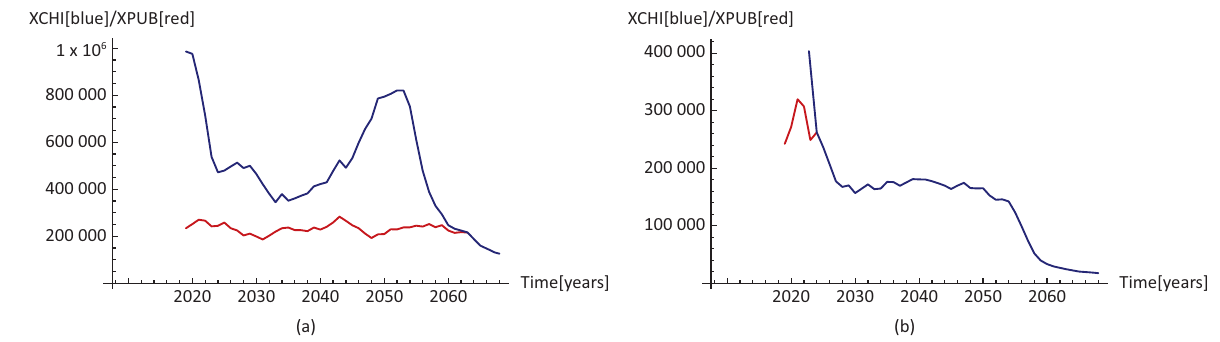
Figure 3. Future simulation (genethic algorithm) of XCHI and XPUB: Spain, 2020–2060. Notes: (a) GA1 (free) and (b) GA2 (conditional on goals consistency).